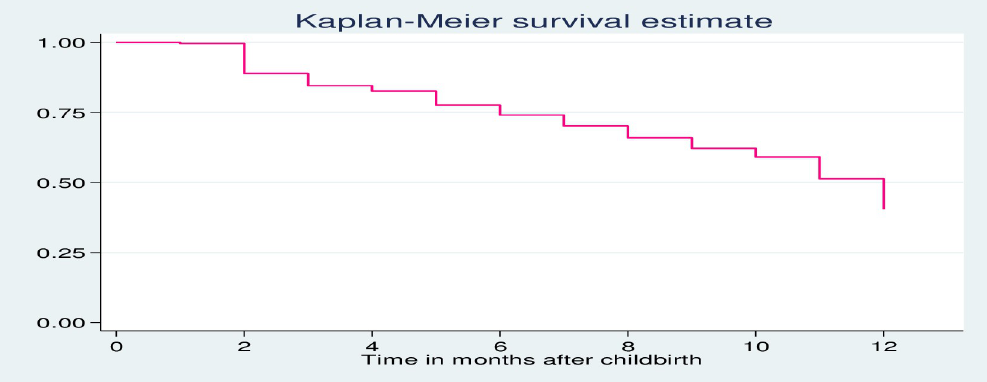
Fig 1. Kaplan Meier survival function curve showing time to modern contraceptive use after birth among reproductive- age women in West Gojjam Zone, Northwest Ethiopia, and June 2018.